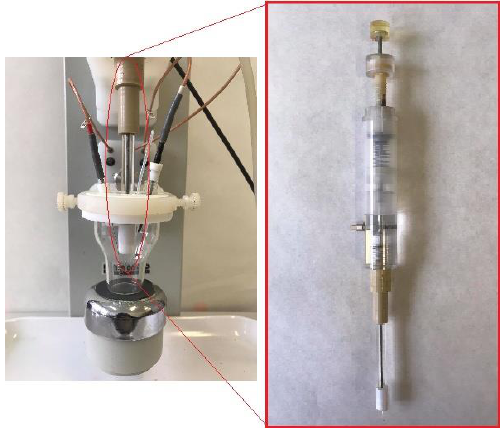
Figure 10. Three-electrode voltammetric cell with the centrally fixed working electrode (R– AgLAFE).